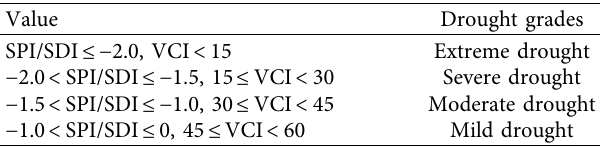
Table 3: Classification of SPI, SDI, and